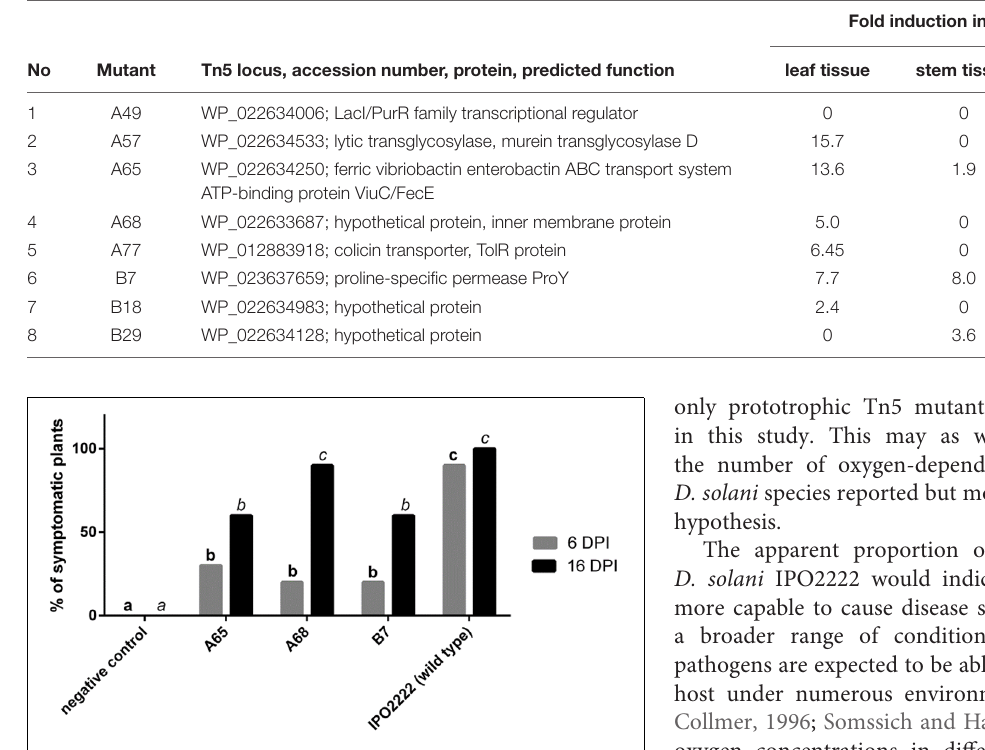
FIGURE 4 | Ability of the three Dickeya solani IPO2222 Tn5 mutants to colonize in vitro grown potato plants cv. Kondor measured as a percentage of symptomatic plants 6 and 16 days post inoculation (DPI). Two week old plants were inoculated with 10 µ l of 10 8 cfu mL − 1 (final:10 6 cfu per plant) suspension of individual D. solani Tn5 mutant (treatment) or wild type D. solani IPO2222 (control) by applying bacterial suspension on the interspace between the stem base and MS medium of each individual plant. As a negative control 10 µ l of sterile 1/4 Ringer’s buffer was used. Each treatment consisted of 10 potato plants grown in individual culture tubes and the entire experiment was repeated independently one time with the same setup ( n = 20 per treatment). Inoculated plants were visually inspected after 6 and 16 dpi for wilting, typical blackleg symptoms, stem desiccation and/or plant